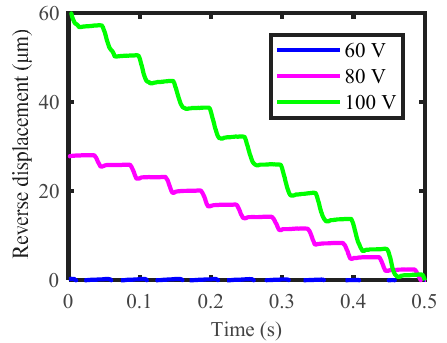
Figure 21. Reverse motion characteristics of the slider under the driving frequency of 20 Hz, various driving voltages, and critical relative gap.